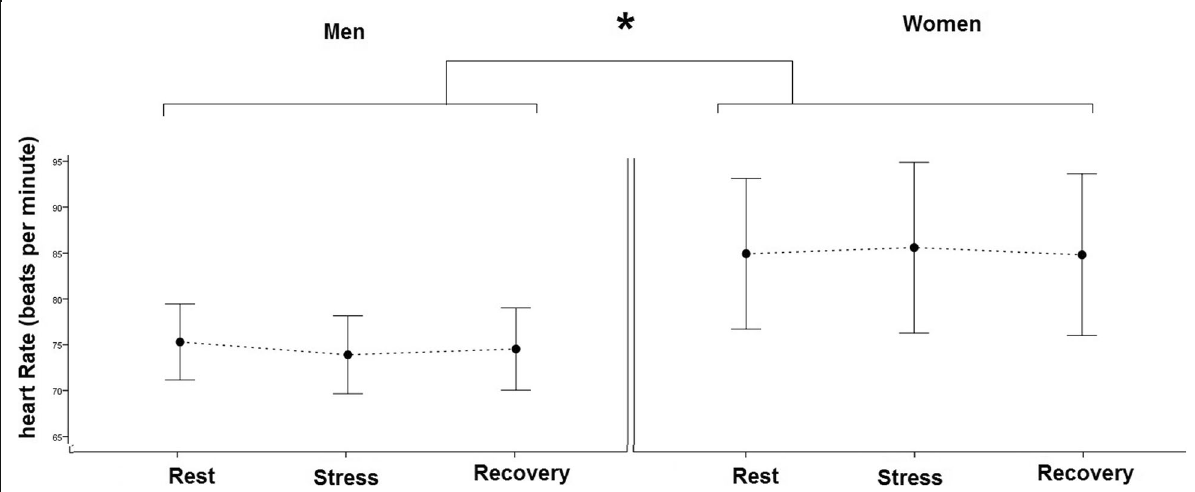
Fig. 4 The mean and CI 95% of heart rate of the men and women in three times of the test. * p < 0.05 between men and